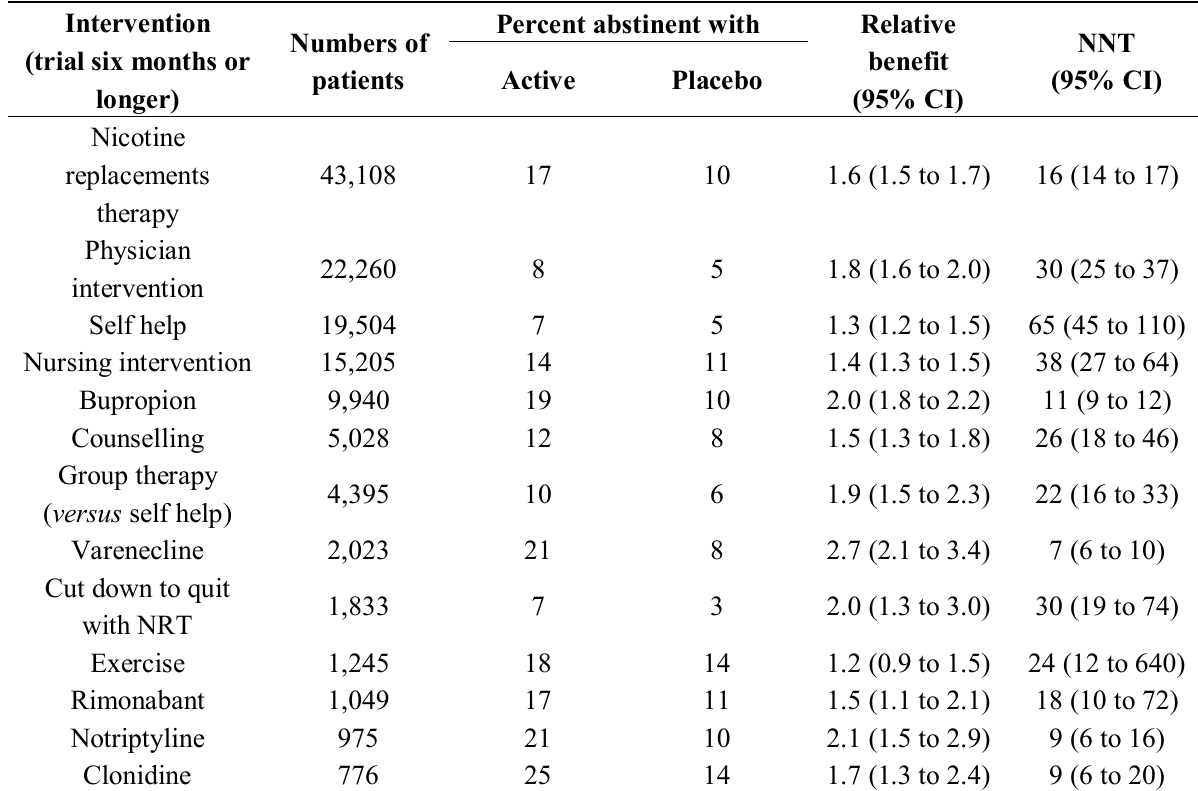
Table 2. Results of smoking cessation reviews, ordered by number of participants. The order is by numbers of participants in the reviews. Intervention is as described in each review, and details of the reviews is in Table 1.